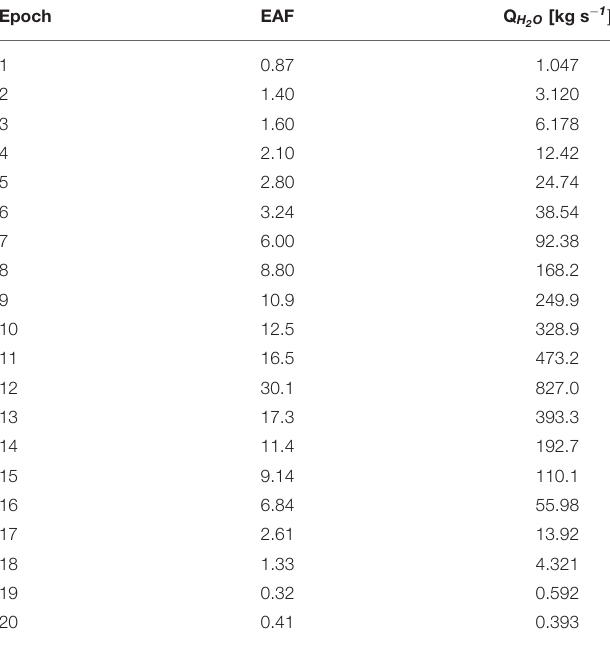
TABLE 2 | The effective active fraction (EAF) assumed and the resulting average H 2 O production rate for each epoch.